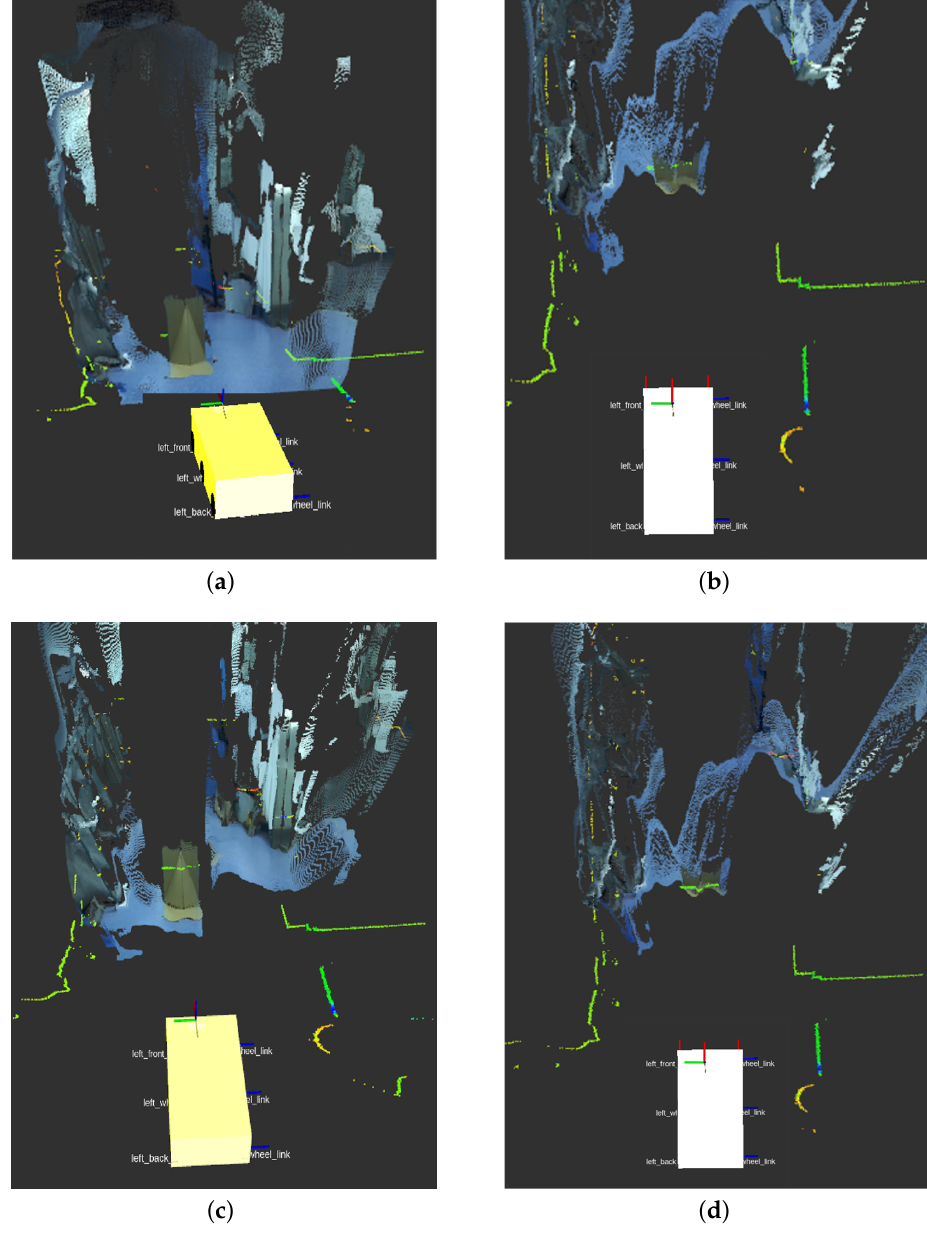
Figure 10. Calibration effect of depth camera and 2D LRF. ( a ) Front view of before calibration. ( b ) Top view before calibration. ( c ) Front view after calibration. ( d ) Top view after